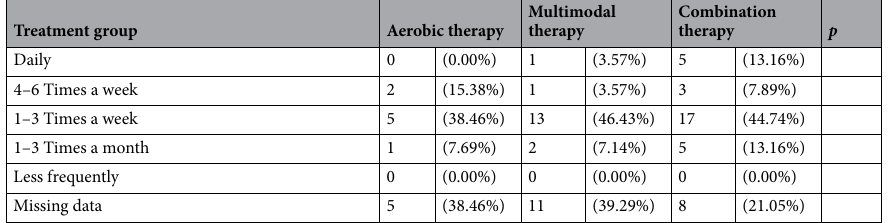
Table 2. Sociodemographic and disease-related sociodemographic data and therapy adherence after four years, n = 79. # Multiple entries per patient possible. SD standard deviation.